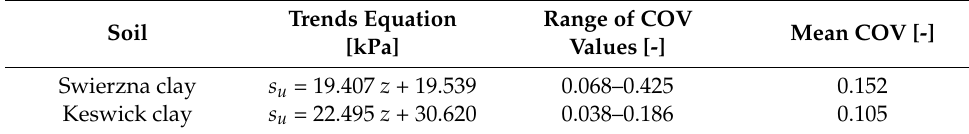
Table 4. Trends in COV values for s u obtained based on CPT results ( z is depth). Trends Soil